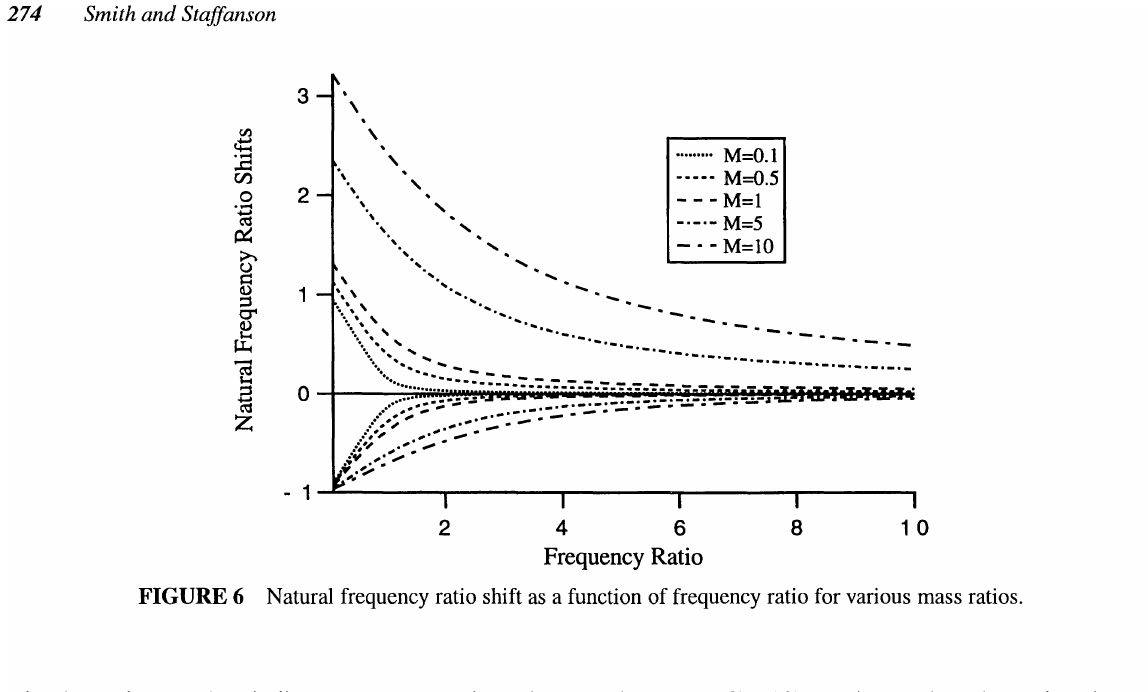
FIGURE 6 Natural frequency ratio shift as a function of frequency ratio for various mass